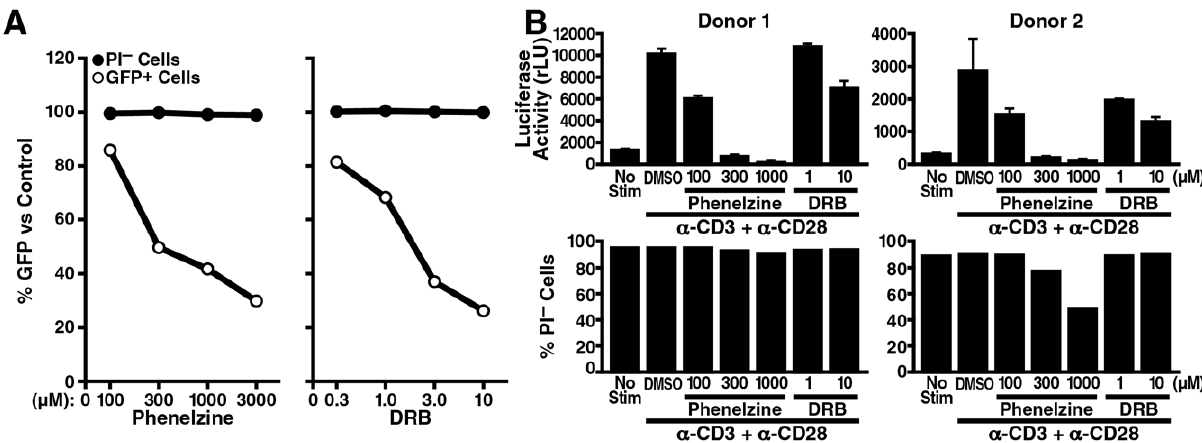
Figure 7. LSD1/KDM1 as a potential drug target in HIV transcription. (A) J-Lat A2 cells were stimulated with 0.08 ng/ml of TNF a in the presence of increasing amounts of phenelzine (100, 300, 1000 or 3000 m M), DRB (0.3, 1, 3 or 10 m M) or DMSO as carrier control overnight. Numbers of GFP + cells (marker of HIV LTR activity) as well as propidium iodide (PI)-negative cells (marker of cell viability) were analyzed by flow cytometry. The percentage compared to DMSO-treated control cells was calculated. The average of two independent experiments is shown. (B) Purified resting primary CD4 + T cells were infected at a high m.o.i. with infectious HIV-NL4-3 luciferase reporter virus. Three days after infection, cells were stimulated with a -CD3 and a -CD28 antibodies in the presence of phenelzine (100, 300, or 1000 m M), DRB (1 or 10 m M) or DMSO overnight followed by analysis for luciferase activity and PI uptake.